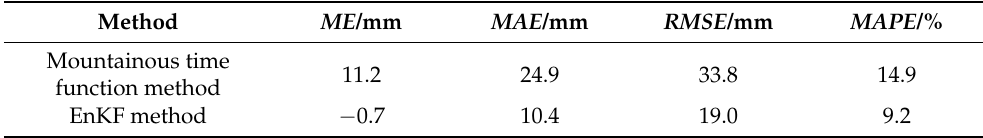
Table 6. Average values of the error indexes for the two